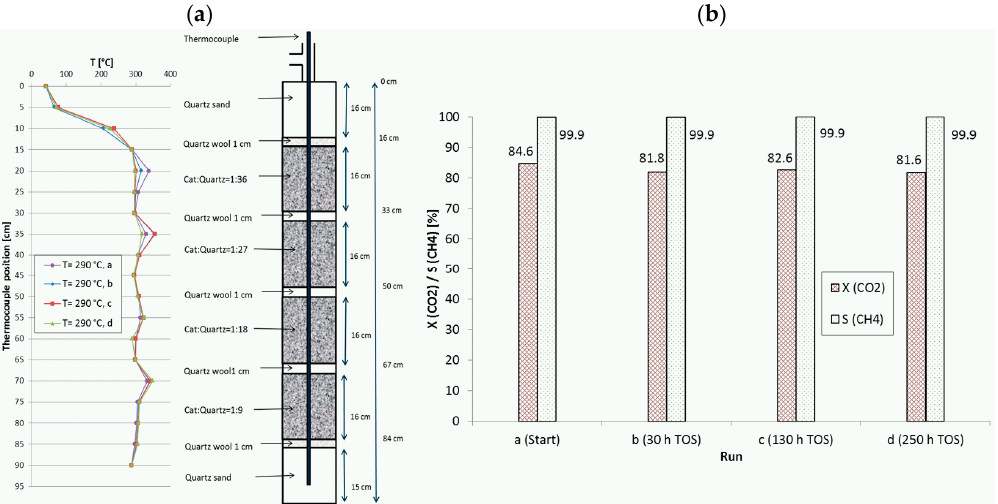
Figure 8. ( a ) Recorded temperature profiles for methanation on 18Ni/Al 2 O 3 in a reactor with four fixed-beds. ( b ) CO 2 conversion and CH 4 selectivity in dependence of TOS. Catalyst:quartz = 1:36, 1:27,